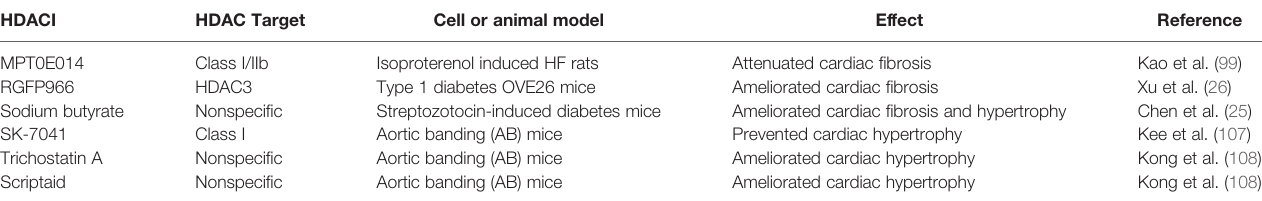
TABLE 2 | Evidence showing the potential effect of inhibitors of HDACs in